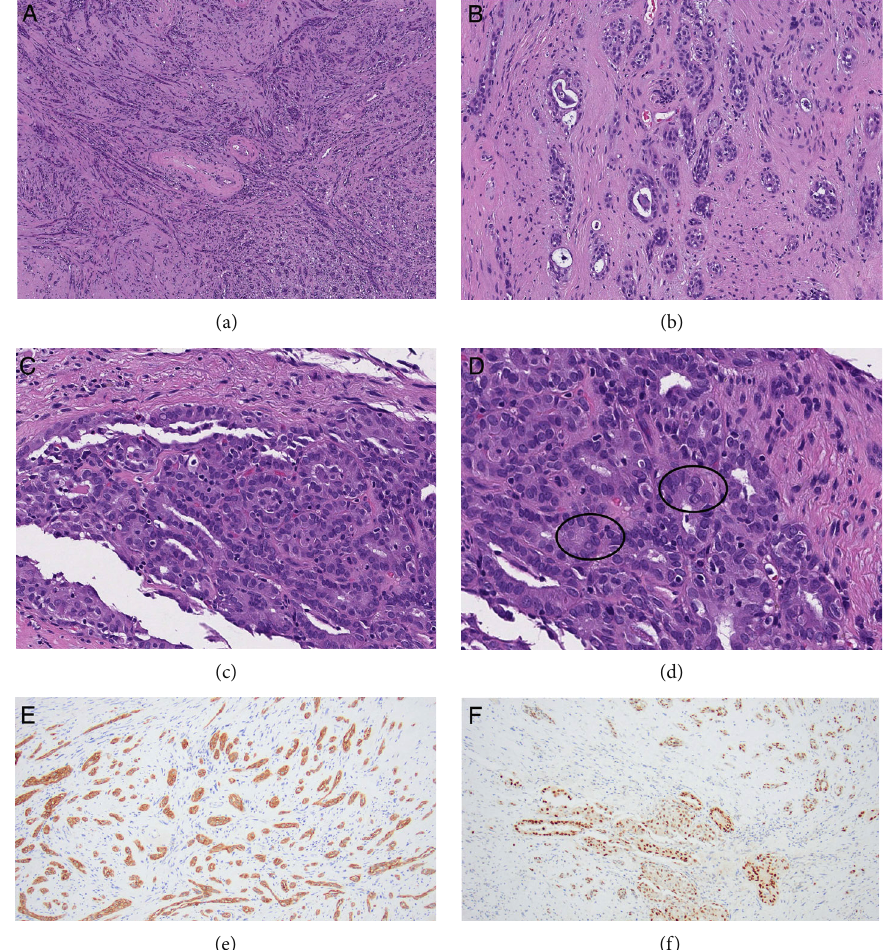
Figure 3: Histopathology of PTC component. Lower magni fi cation images ((a) 40x and (b) 100x) and higher magni fi cation images ((c) 200x and (d) 400x) highlight the metastatic cells arranged in glands. These cells exhibit classical nuclear features of papillary thyroid carcinoma including nuclear grooves and intranuclear pseudoinclusions ((d) circled). Immunohistochemistry for AE1/AE3 (e) and PAX8 (f) are positive within the glands, con fi rmatory for metastatic